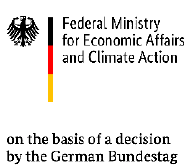
Figure 7. Realized 3D-rCFRP demonstrator